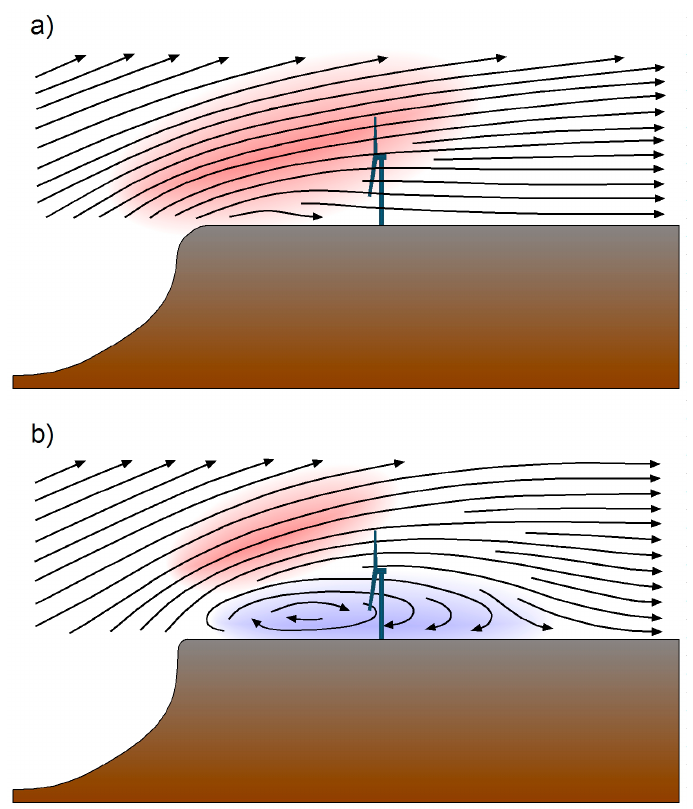
Figure 6. Airflow illustration of the mean flow field over topography with a rounded edge ( a ) and a sharp edge ( b ). Red and blue shading indicate areas with strong and weak horizontal winds, respectively. Adapted from [86].